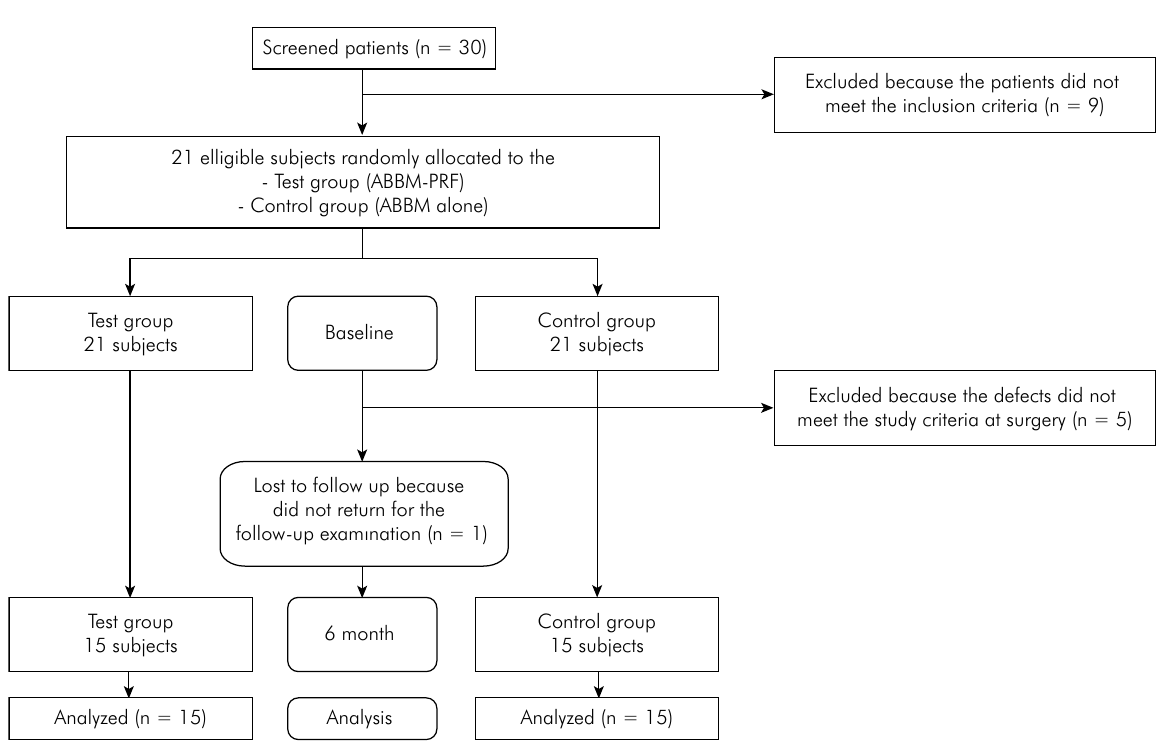
Figure 2. Consort flow chart of the study.